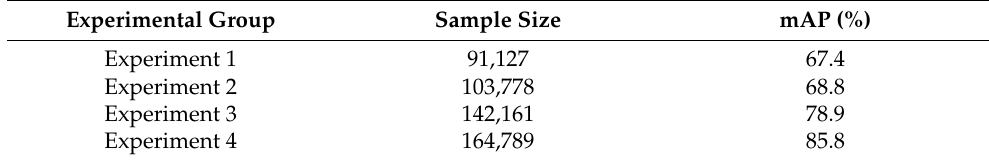
Table 7. Results of each